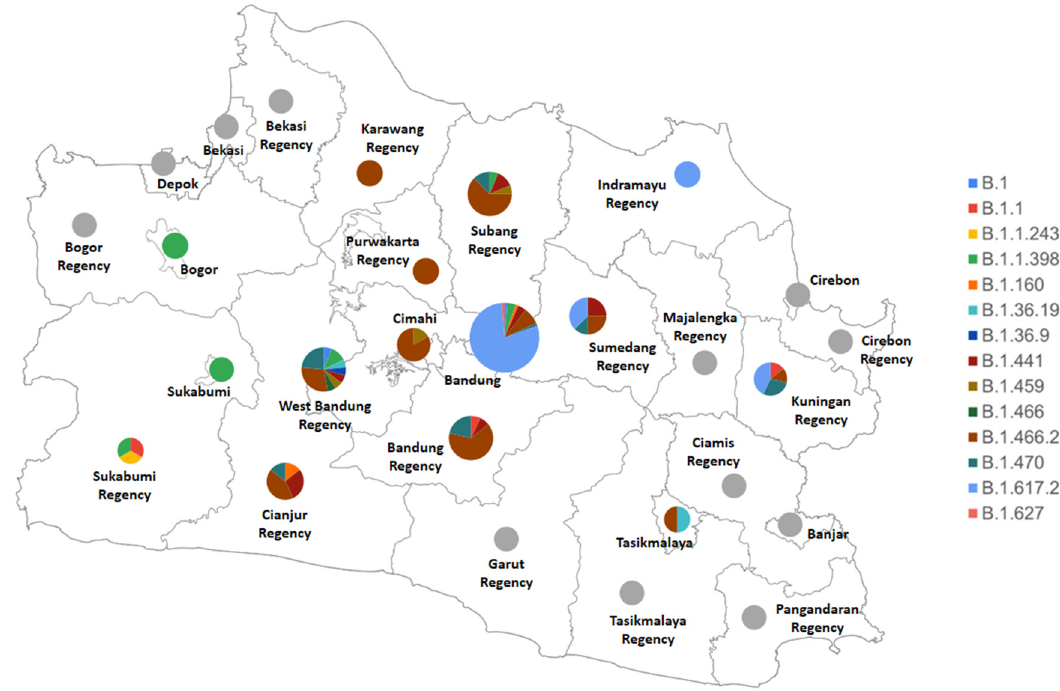
Figure 3. Map of diversity of SARS-CoV-2 variants circulating in each city and district of West Java, Indonesia in September 2020–June 2021. Grey color indicates absence of samples from the city/regency.